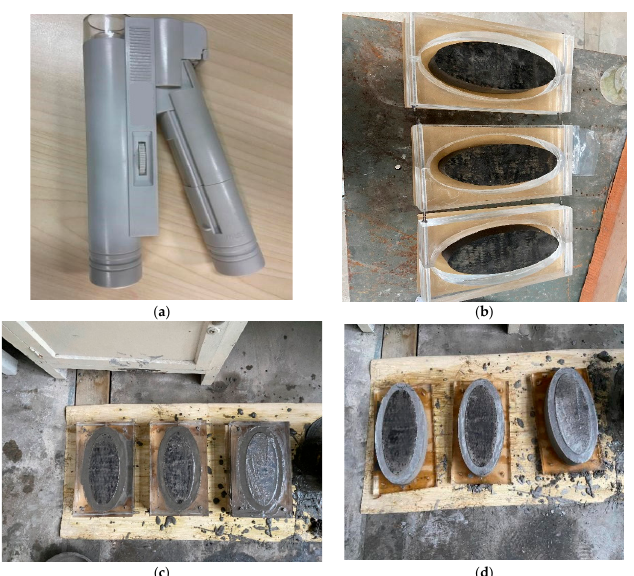
Figure 5. Apparatus for cracking test: ( a ) reading microscope; ( b ) oval mold; ( c ) casting the specimens; ( d ) specimen